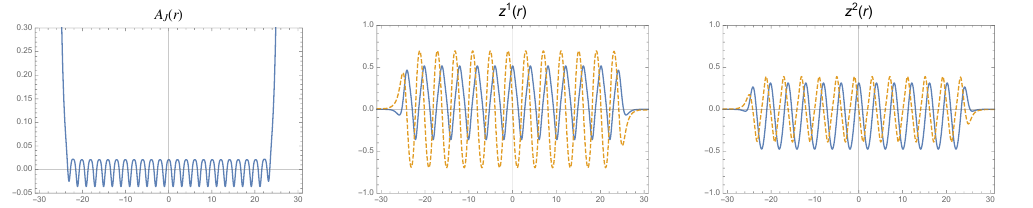
Figure 5. For the N = 1 ∗ equal mass model as ( α 1 ) tp → α crit , approaching the red curve in figure 3, the N = 4 SYM Janus solutions have a radial region approaching a solution that is periodic in the radial coordinate. For any − α crit < ( α 1 ) tp < α crit , the solution is a Janus solution and so A J → ± r/L and z A → 0 as r → ±∞ . Both the period and shape of the middle region is essentially unchanged as we approach the critical solution, with just more periods appearing, and clearly reveals the functional form of the periodic solution. The blue and orange curves are the real and imaginary components of z 1 , z 2 ,